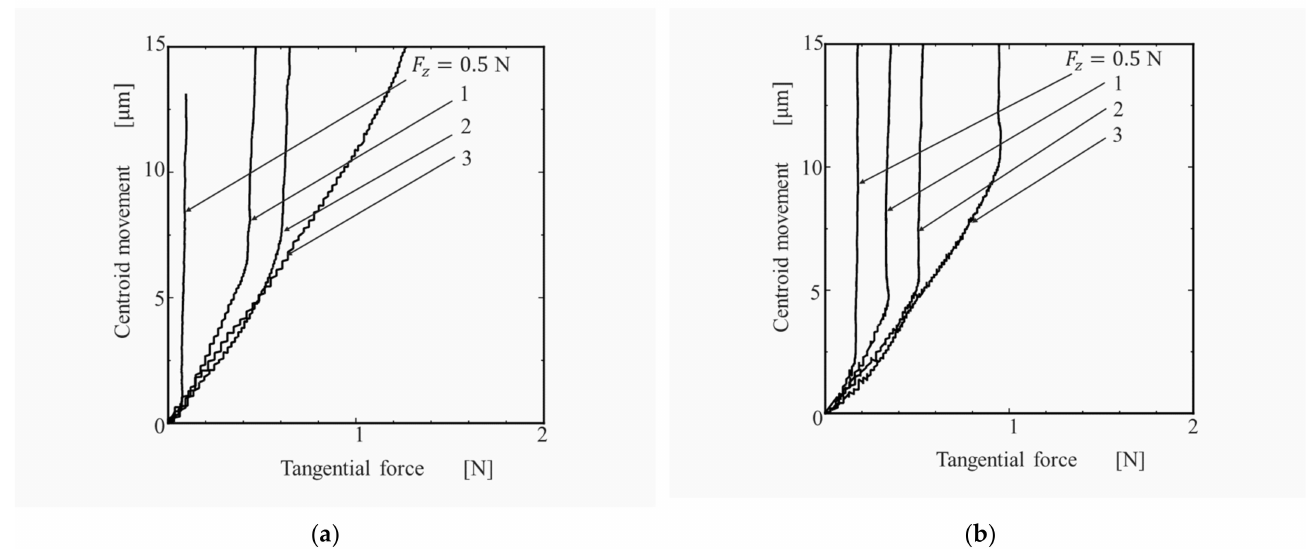
Figure 10. Results of tangential force test: ( a ) longitudinal tangential force and ( b ) transverse tangential force. Since the critical tangential force, which causes the bending point, increases with an increase in normal force, this tactile sensor follows the famous physical phenomenon of the laws of dry